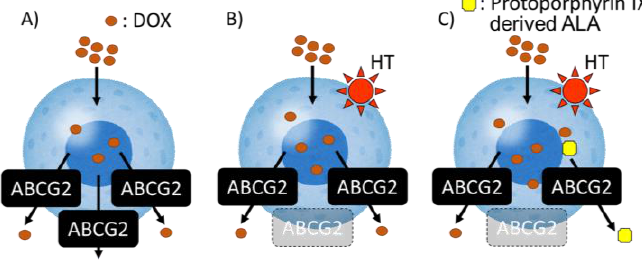
Figure 7. The mechanism of cell death in this study. ( A ) DOX is efflux from ABCG2. ( B ) HT can downregulate the ABCG2 expression. ( C ) Porphyrin is introduced by ALA and is excreted by ABCG2. ALA worked as a competitive inhibitor of DOX excretion transporter to enhance cell death.